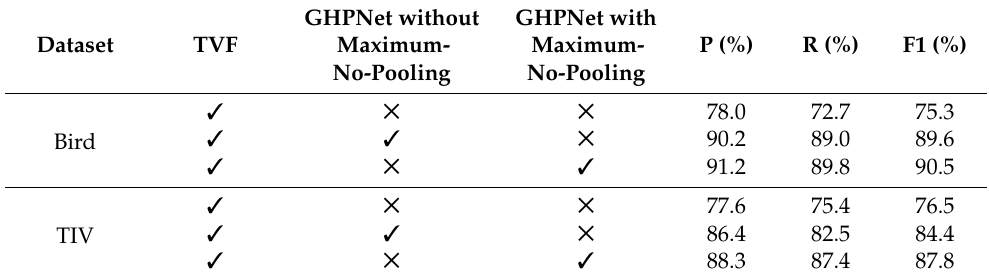
Figure 9. Comparison of first-stage and second-stage detection results on TIV dataset, ( a ) the detec- tion result of TVF; ( b ) the detection result of GHPNet combined with TVF. Table 6. Ablation Experiment. Table 6. Ablation Experiment.